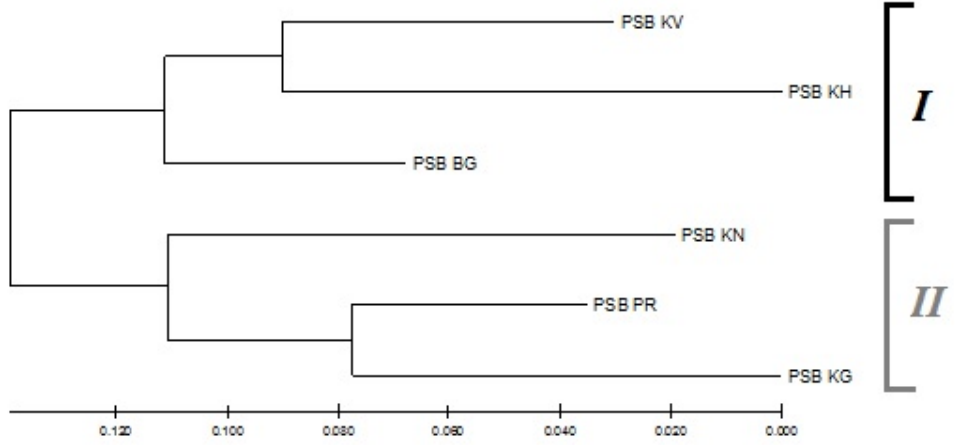
Figure 3. Dendrogram of genetic similarity of six studied populations of P. sibirica, built based on polymorphism of ISSR profiles by neighbor-joining method (I, II - cluster numbers).